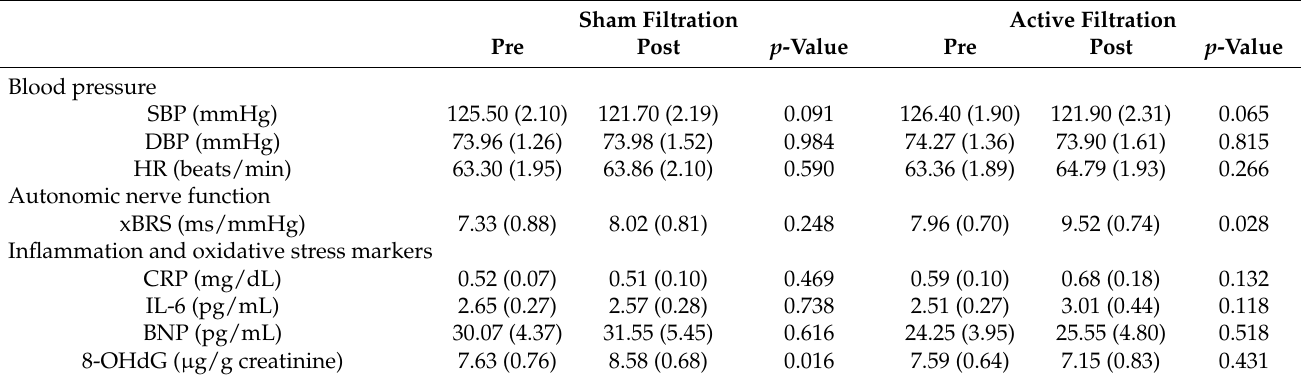
Table 3. Changes of health outcomes between pre- and post-intervention according to interven- tion phase. Sham Filtration Active Filtration Pre Post p -Value Pre Post p -Value